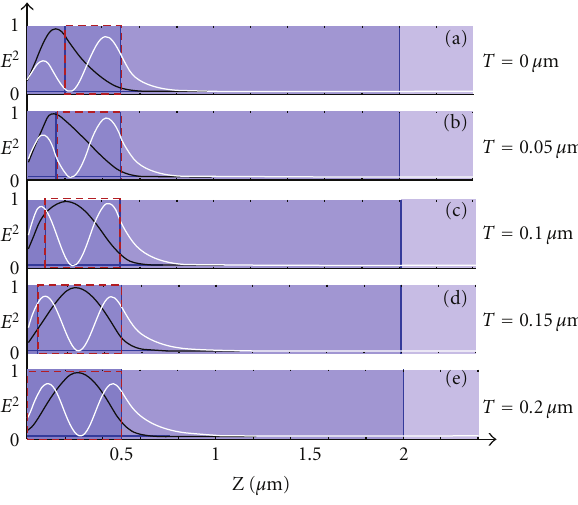
Figure 10: The vertical low-order modes profiles of the OLEDs structure with PhCs embedded into organic layer. The region in the red rectangle is the PhCs